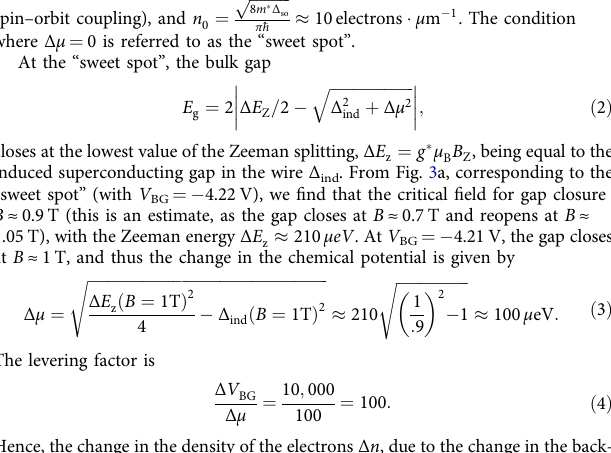
ffiffiffiffiffiffiffiffiffiffiffiffiffiffiffiffiffiffiffiffiffiffi Δ 2 þ Δ μ 2 ind